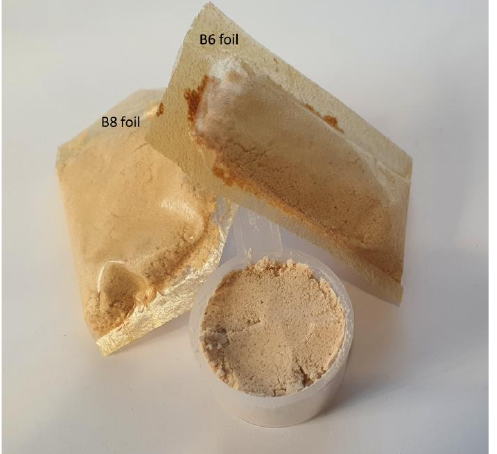
Figure 3. Examples of potential applications of developed films: protein powder packed in biopoly- meric foils with orange ( B6 ) and cinnamon ( B8 ) EO added. Each package contains a measure of protein powder, according to the manufacturer. The packages are glued by hot thermowelding (180 ◦ C, 20 s). The addition of orange and cinnamon EO may improve the sensorial properties of such powders and may sustain beneficial effect on